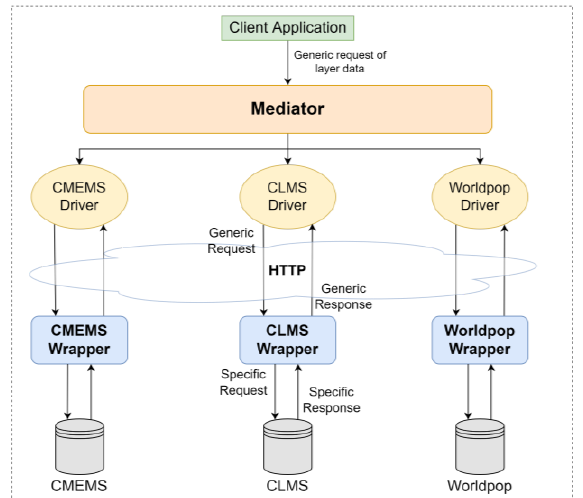
Figure 3. Mediator-wrapper